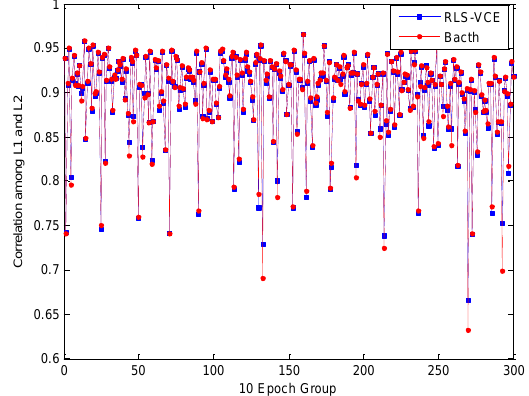
Fig. 3 Estimated correlations among phase observations on L1 and L2 frequencies for Trimble R7 receiver for both batch and recursive